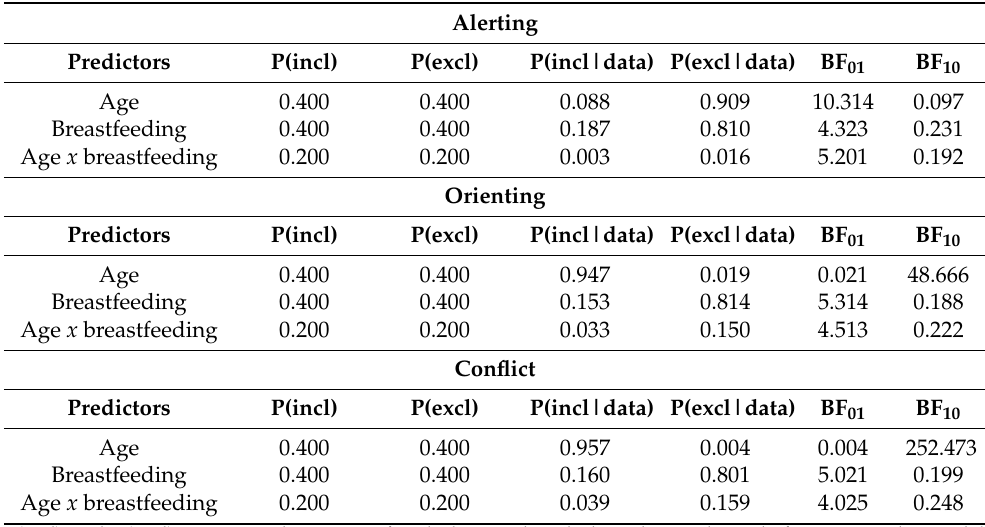
Table 3. Analysis of the effects in the Bayesian ANOVAs conducted on the measures of alerting, orienting, and conflict, derived by the